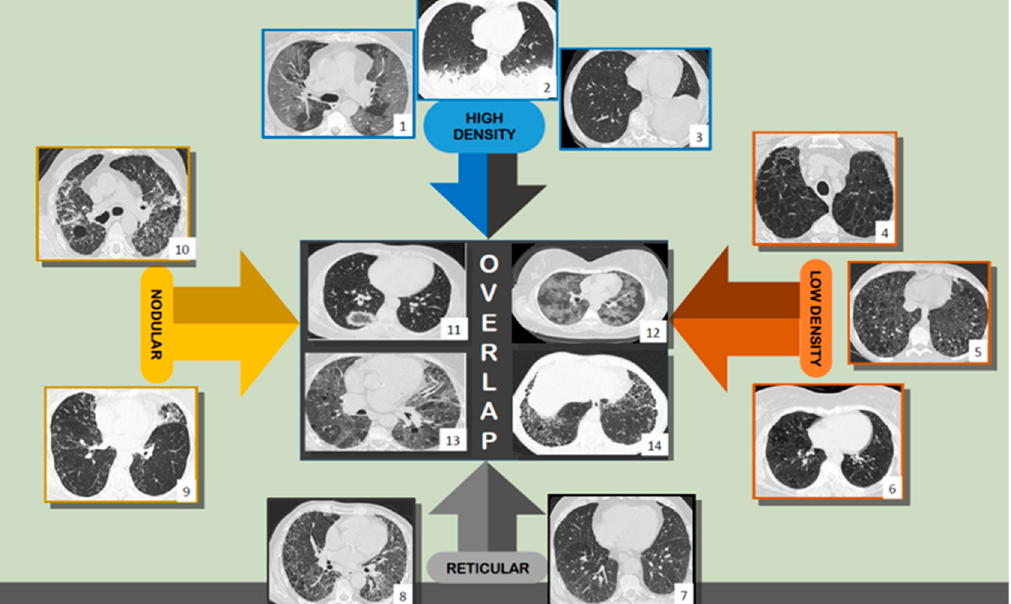
Figure 1. Axial thin-section CT scans, injury patterns: high density (1, 2, 3), low density (4, 5, 6), reticular (7, 8), nodular pattern (9, 10), and overlapping (11, 12, 13, 14). Scans belong to the ‘Dr. Victor Babes’ Infectious Diseases and Pneumoftiziology Clinical Hospital Timisoara database.